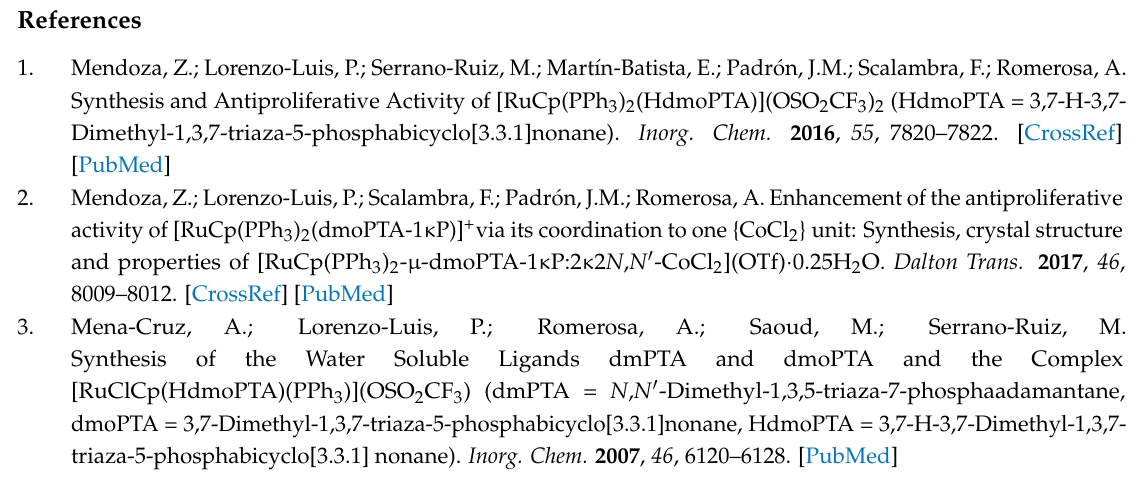
Figure S1: TGA curves of the complexes 1 – 4 , Table S1: Crystal data and structure refinement for complexes 1 – 4